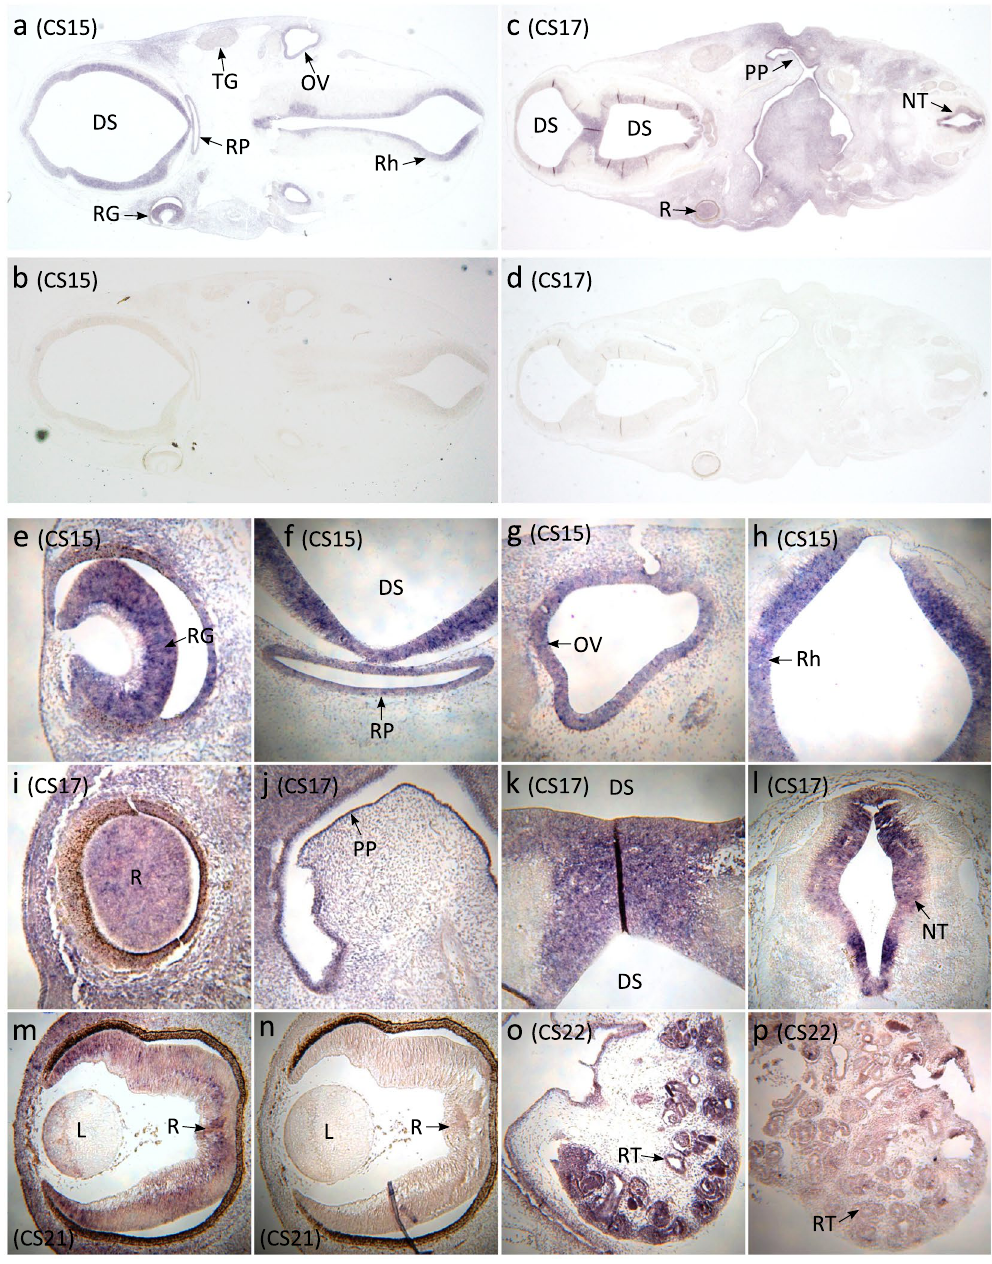
Figure 3. YAP1 in situ hybridisation studies in the developing human. ( a , b ) In situ hybridisations of coronal sections of a CS15 human fetus using YAP1 antisense ( a ) and sense (negative control) ( b ) probes reveal expression in structures including the diencephalic superventricle (future third ventricle), retinal ganglion cell layer, Rathke’s pouch (future pituitary), trigeminal ganglion, otic vesicle, and rhombencephalon (future fourth ventricle). ( c , d ) In situ hybridisations of coronal sagittal sections of a CS17 human fetus using YAP1 antisense ( c ) and sense (negative control) ( d ) show expression of YAP1 in diencephalic superventricle, retina, primordium of the lateral palatine process, and neural tube. ( e–h ) High magnification images of YAP1 expression in the CS15 human fetus in multiple structures: ( e ) retinal ganglion cell layer, ( f ) diencephalic superventricle and Rathke’s pouch, ( g ) otic vesicle, and ( h ) rhombencephalon. ( i–l ) High magnification images of YAP1 expression in the CS17 human fetus in multiple structures: ( i ) retina, ( j ) primordium of the lateral palatine process, ( k ) diencephalic superventricle, and ( l ) the neural tube. ( m , n ) High magnification images of YAP1 expression in the retina of CS21 human fetus: ( m ) antisense, and ( n ) sense. ( o , p ) High magnification images of YAP1 expression in the kidney of CS22 human fetus: ( o ) antisense, and ( p ) sense. Abbreviations: DS = diencephalic superventricle; L = lens; NT = neural tube; OV = otic vesicle; PP = primordium of the lateral palatine process; R = retina; RG = retinal ganglion cell layer; Rh = rhombencephalon; RP = Rathke’s pouch; RT = renal tubules; TG = trigeminal